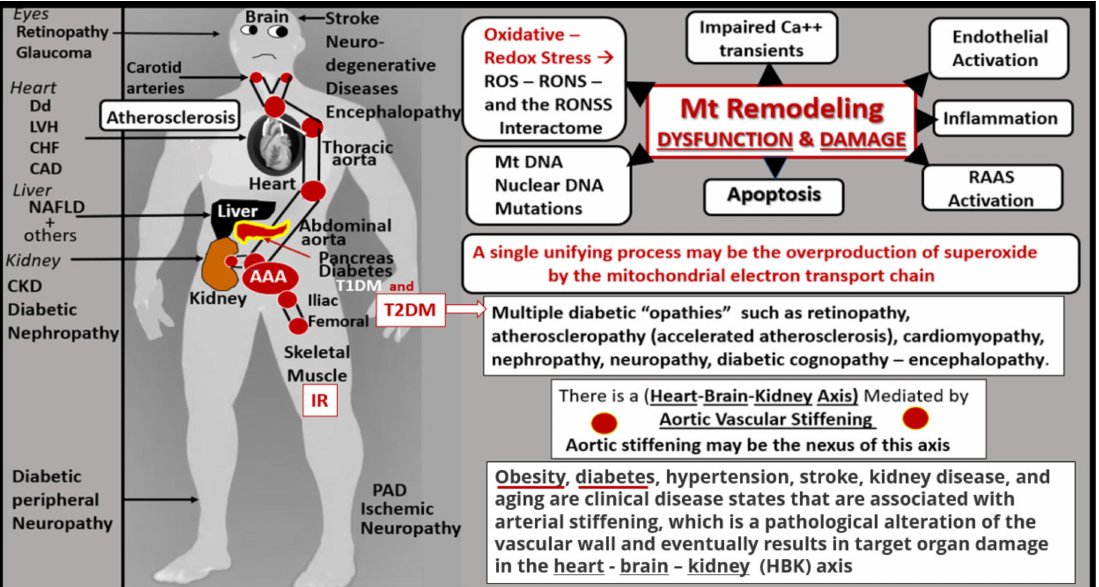
Figure 3. Mitochondria (Mt) remodeling to an aberrant Mt (aMt) phenotype with dysfunction and damage to organ systems. This figure is an illustration of proposed mitochondrial-mediated mechanisms of disease development and progression associated with aMt dysfunction and damage that have been implicated in numerous organ systems and clinical diseases (left-hand standing man image). Oxidative—redox stress includes the sum of reactive oxygen species (ROS), reactive nitrogen species (RNS), and reactive sulfur species (RSS) to create the reactive oxygen, nitrogen, sulfur species (RONSS) interactome. Importantly, aortic stiffening may be the nexus for a heart- brain-kidney axis (red circles) illustrating the aortic vascular pathway of vascular stiffening to affect the carotid and renal arteries and target organs of the heart-brain-kidney axis. AAA = abdominal aortic aneurysm; Ca++ = calcium transients; CAD = coronary artery disease; CHF = congestive heart failure; CKD = chronic kidney disease; Dd = diastolic dysfunction; DNA = deoxyribonucleic acid; IR = insulin resistance; LVH = left ventricular hypertrophy; NAFLD = non-alcoholic fatty liver disease; PAD = peripheral arterial disease; RAAS = renin-angiotensin-aldosterone system; T1DM = type 1 diabetes mellitus; T2DM = type 2 diabetes